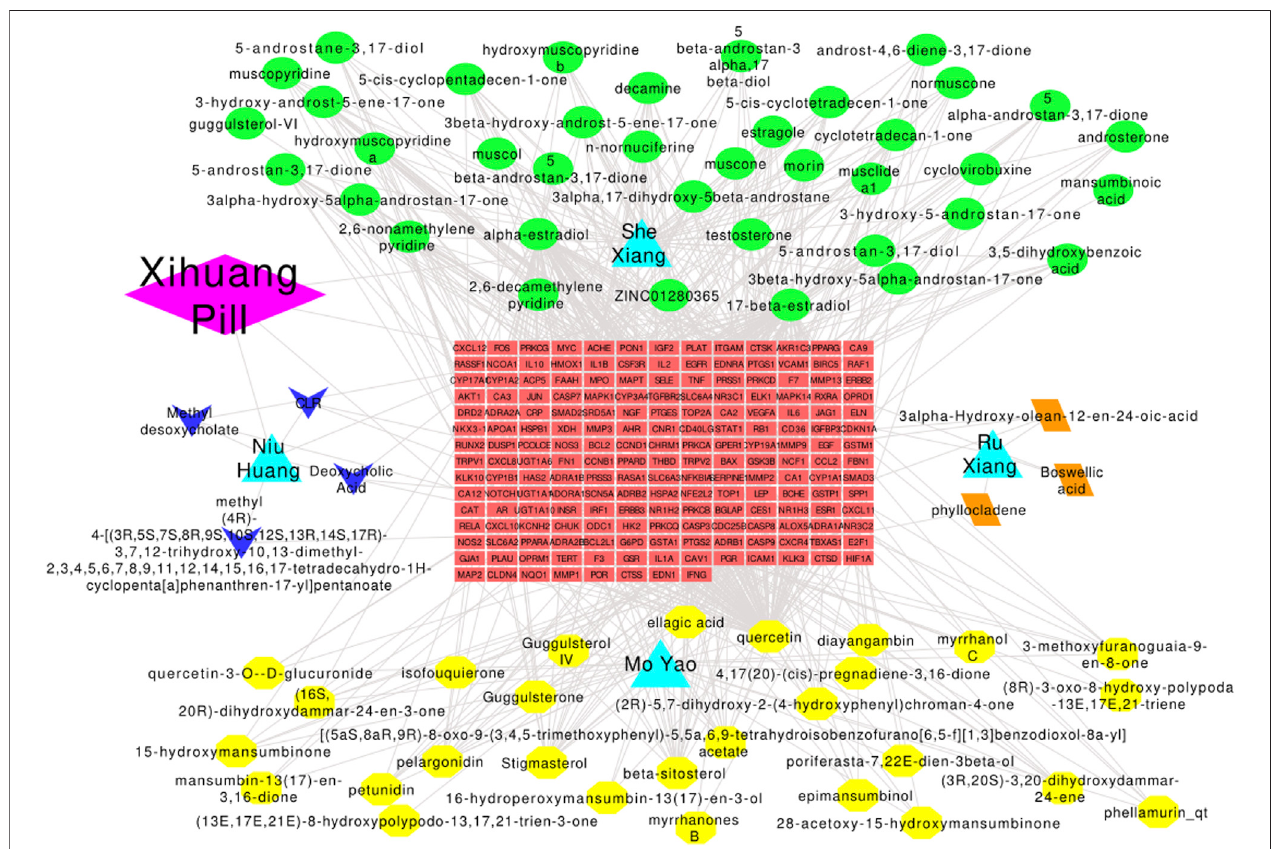
FIGURE 4 | Drug – herbs – active compounds – target genes – disease network. Diamond: drugs; triangle: herbs; green-ellipse: active compounds of Shei Xiang; yellow-ellipse: active compounds of Mo Yao; arrow: active compounds of Niu Huang; parallelogram: active compounds of Ru Xiang; rectangle: target genes.